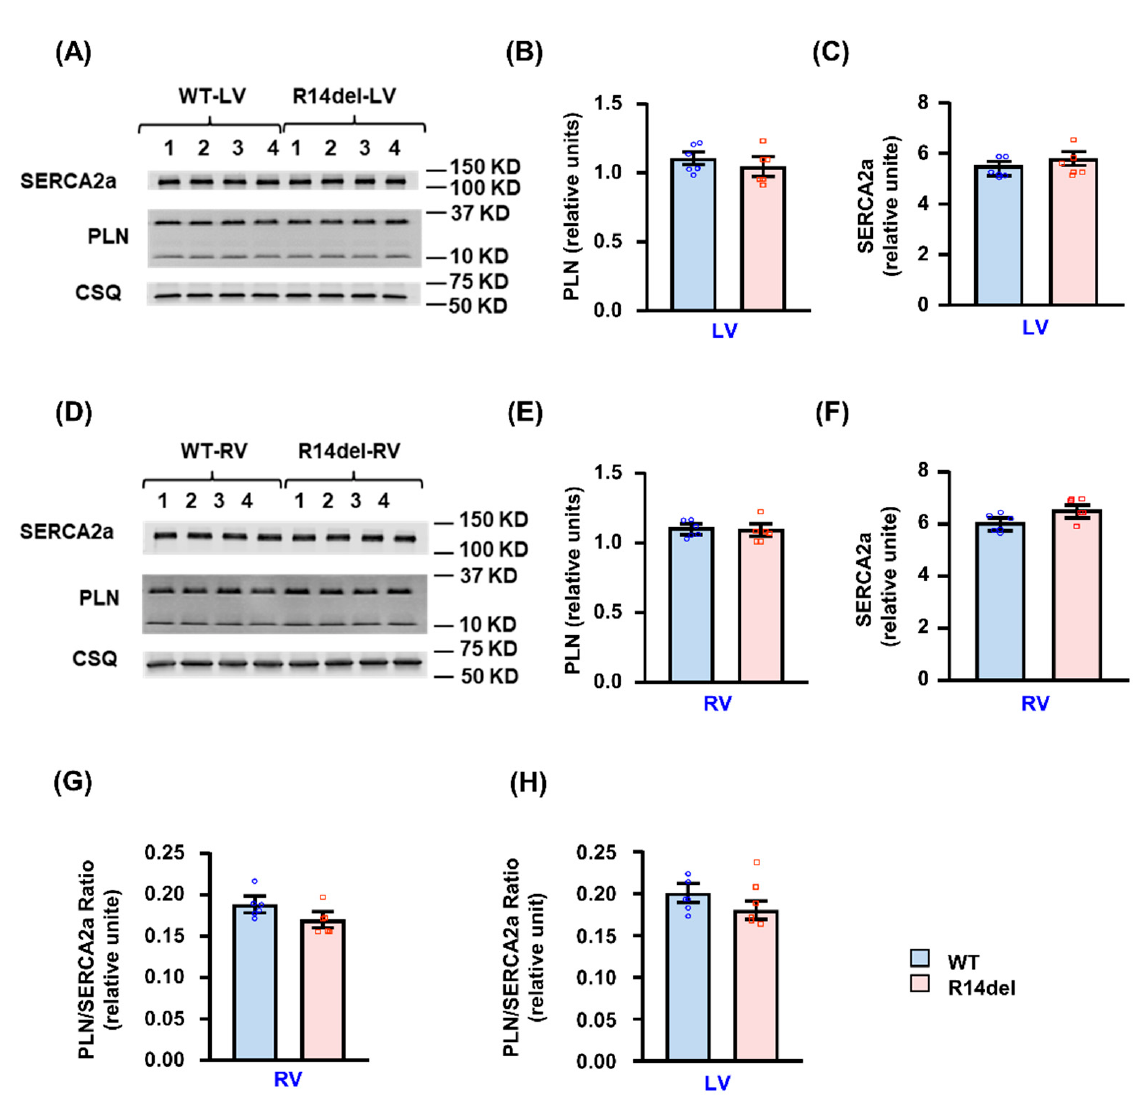
Figure 7. Assessment of PLN levels in LV and RV. ( A ) Representative immunoblots of PLN and SERCA2a protein levels in LV from WT-PLN and R14del-PLN. ( B ) Quantitative assessment of PLN protein levels in LV. ( C ) Quantitative assessment of SERCA2a protein levels in LV. Calsequestrin (CSQ) was used as a loading control. N = 6 LV samples from WT and N = 6 LV samples from R14del-PLN mice. ( D ) Representative immunoblots of PLN and SERCA2a protein levels in RV from WT-PLN and R14del-PLN. ( E ) Quantitative assessment of PLN protein levels in RV. ( F ) Quantitative assessment of SERCA2a protein levels in RV. Calsequestrin (CSQ) was used as a loading control. N = 6 RV samples from WT and N = 6 RV samples from R14del-PLN mice. ( G , H ) The PLN/SERCA2a ratio in RV and LV samples. Twelve- to fourteen-week-old male mice were used. Data are expressed as mean ± SEM for the number of hearts and statistical analyses were performed by two-tailed unpaired t -test. A p -value of <0.05 was considered statistically